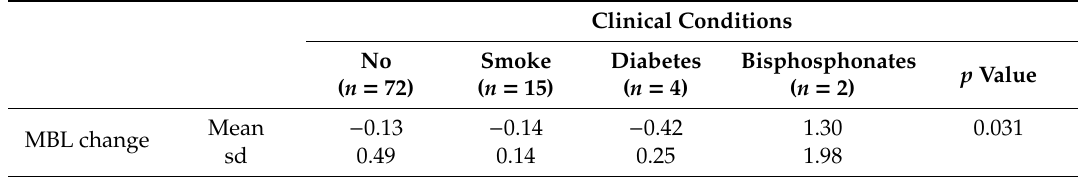
Table 5. Mean MBL change (mm) calculated for each patient based on clinical systemic conditions. “No” stands for healthy patients with no clinical condition. sd: Standard Deviation.